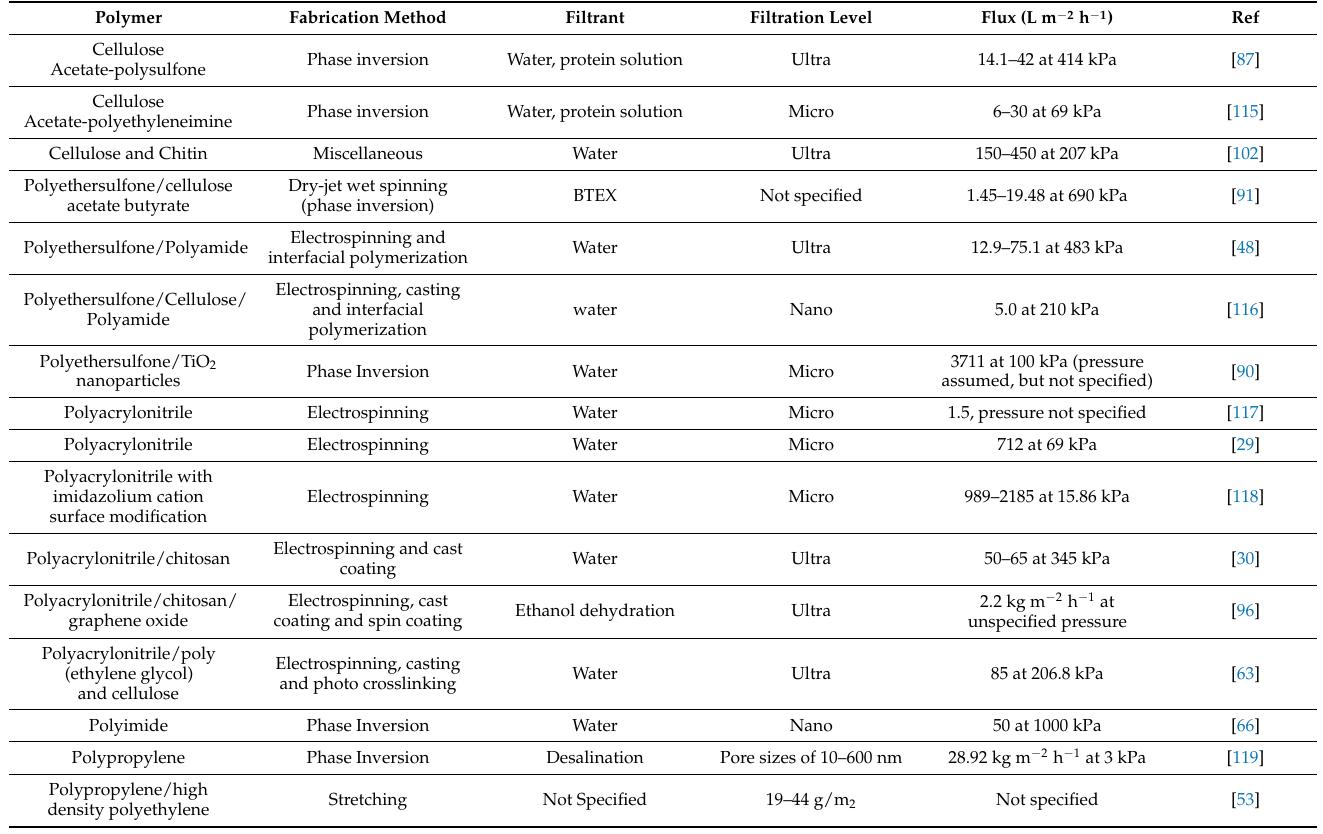
Table 2. Summary of polymers used and the resulting membrane